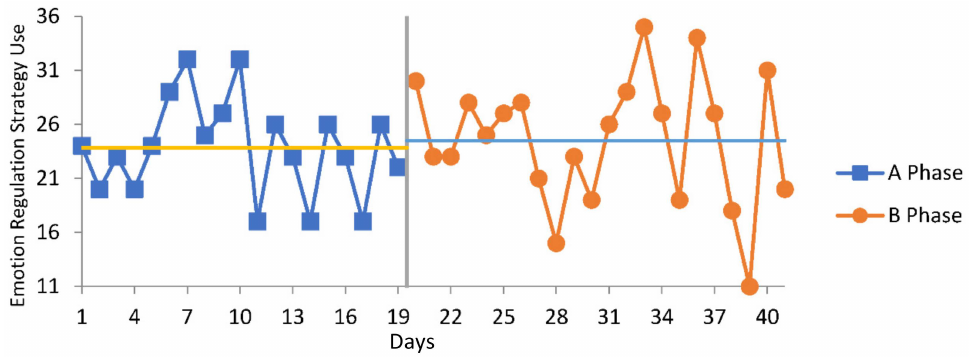
Figure 3. Emotion Regulation Strategy Use changes from phase A to B for P2.